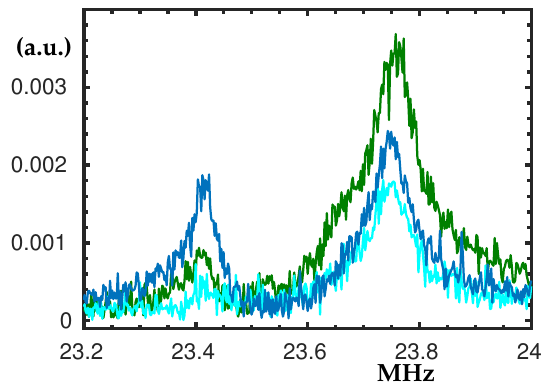
Figure A7. Experimental frequency swipe-up centred at about 23.6 MHz for V pp = 18 V, where the blue, cyan and green curves denote V of f = 0 V, V of f = 3 V and V of f = 5 V, respectively.